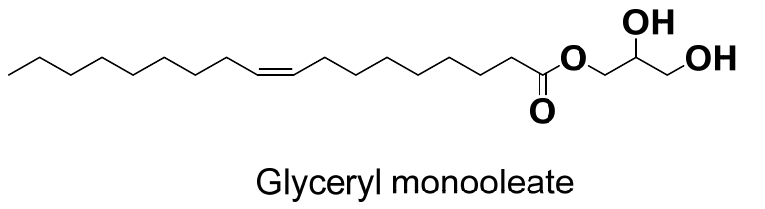
Figure 2. Molecular structure of GMO.